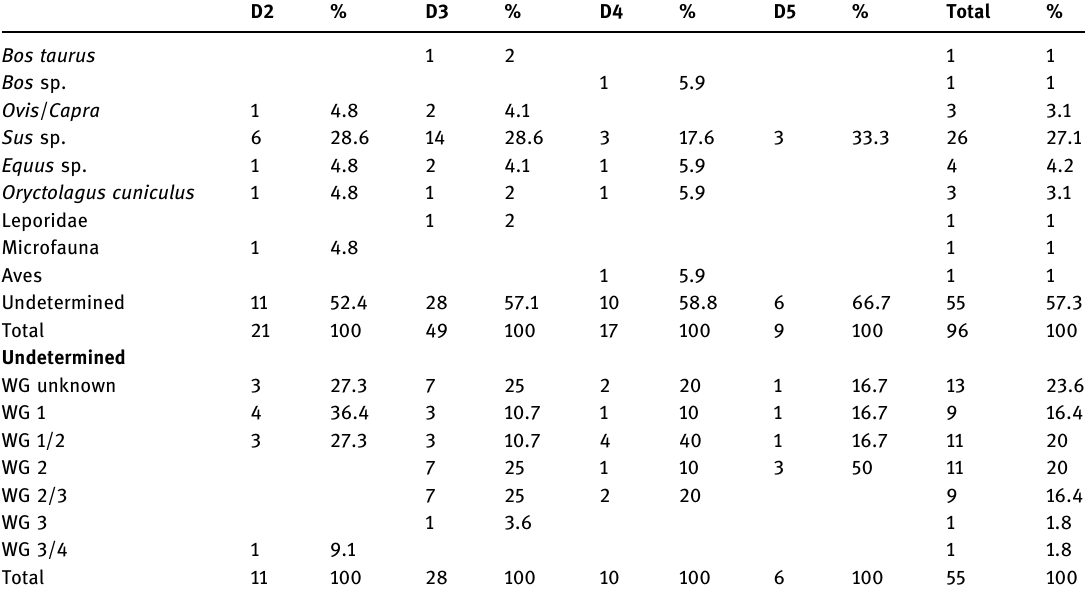
Table 7: Absolute and relative values on the presence of burning damage according to taxa and degree ( D ) of damage for pit 40 D2 % D3 % Bos taurus Bos sp. Sus sp.